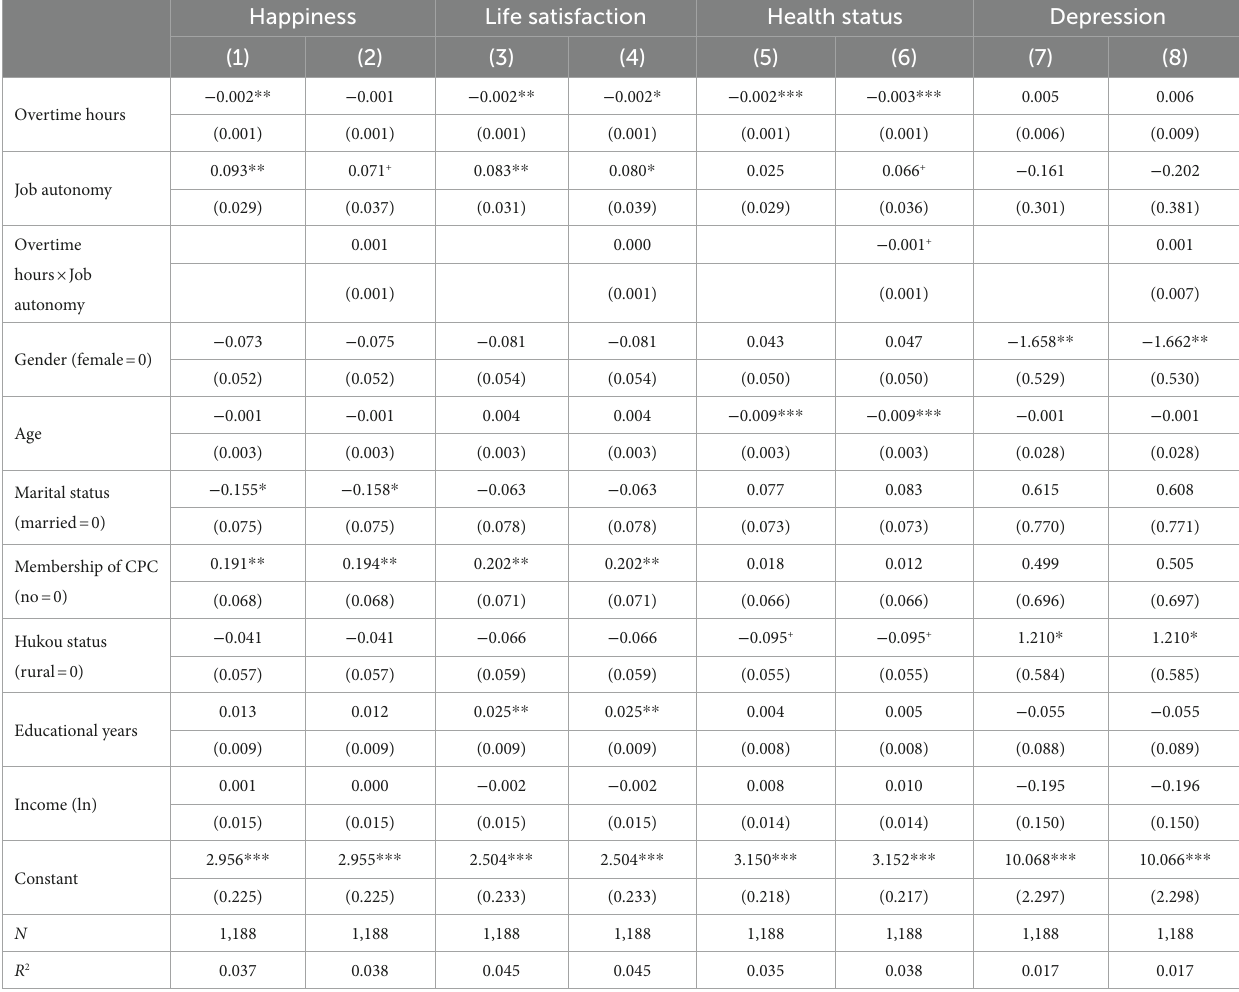
TABLE 3 Multiple linear regression analysis of overtime hours and job